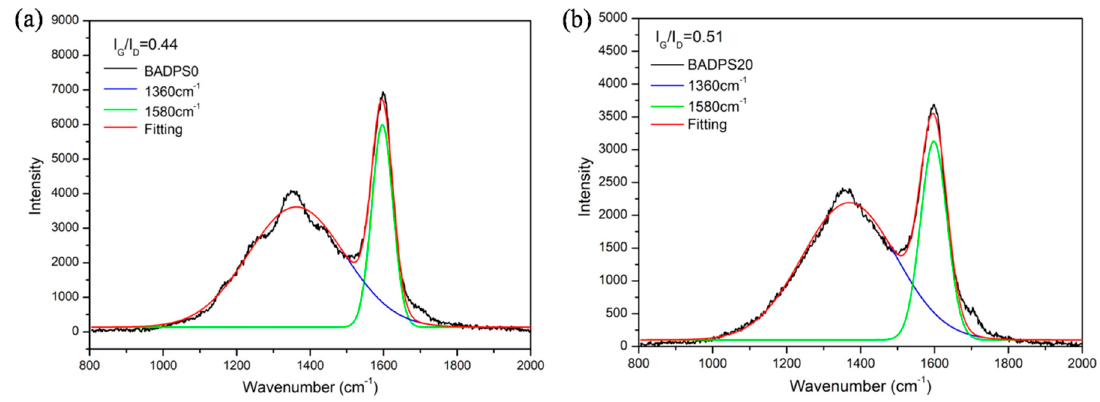
Figure 10. Raman spectra of the char residues for BADPS0 and BADPS20.